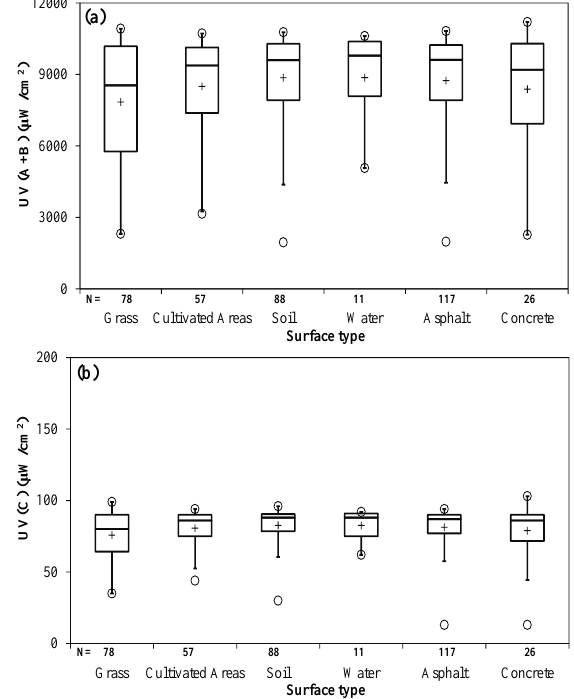
Figure 5. Distribution of UV (A+B) (a) and UV (C) (b) solar irradiances across different land cover types (the upper and lower bounds of the box plots indicate the Q3-Q2 and Q2-Q1 quartiles of the values, the whiskers represent the Q3- extreme outlier and extreme outlier -Q1 quartiles, the cross represents the mean, the midlines represent median, and the top and bottom ellipses illustrate the maximum and minimum values, respectively). N is the number of observations for each land cover